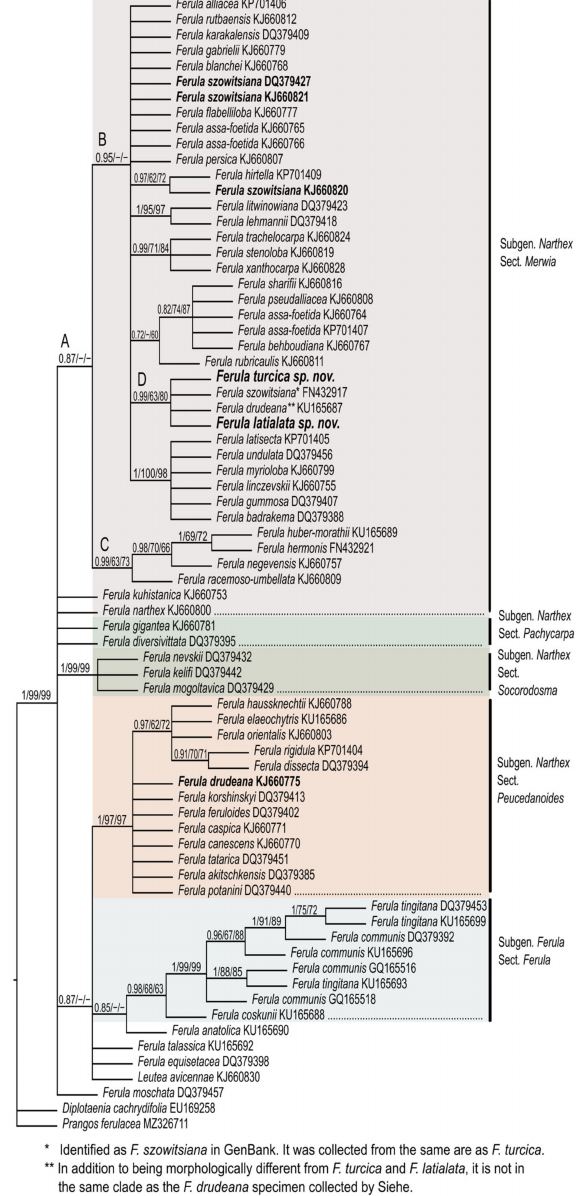
Figure 7. Bayesian estimate of the phylogeny of the genus Ferula focused on subgenus Narthex based on the ITS sequence dataset. The two new species described herein, F. turcica and F. latialata , and related species, F. szowitsiana and F. drudeana , are indicated by bold letters. The supporting posterior probability and bootstrap values (the first obtained from maximum likelihood analysis; the second obtained from maximum parsimony analysis) are presented above the branches. Alphabetical designations for some clades are addressed in the main